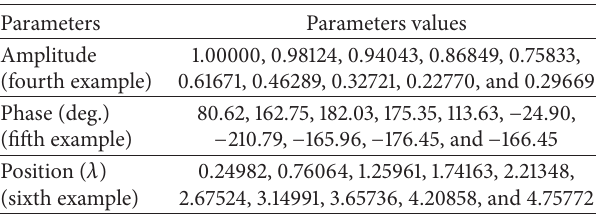
Table 5: Antenna arrays parameters values obtained by DS for the fourth, fifth, and sixth examples.